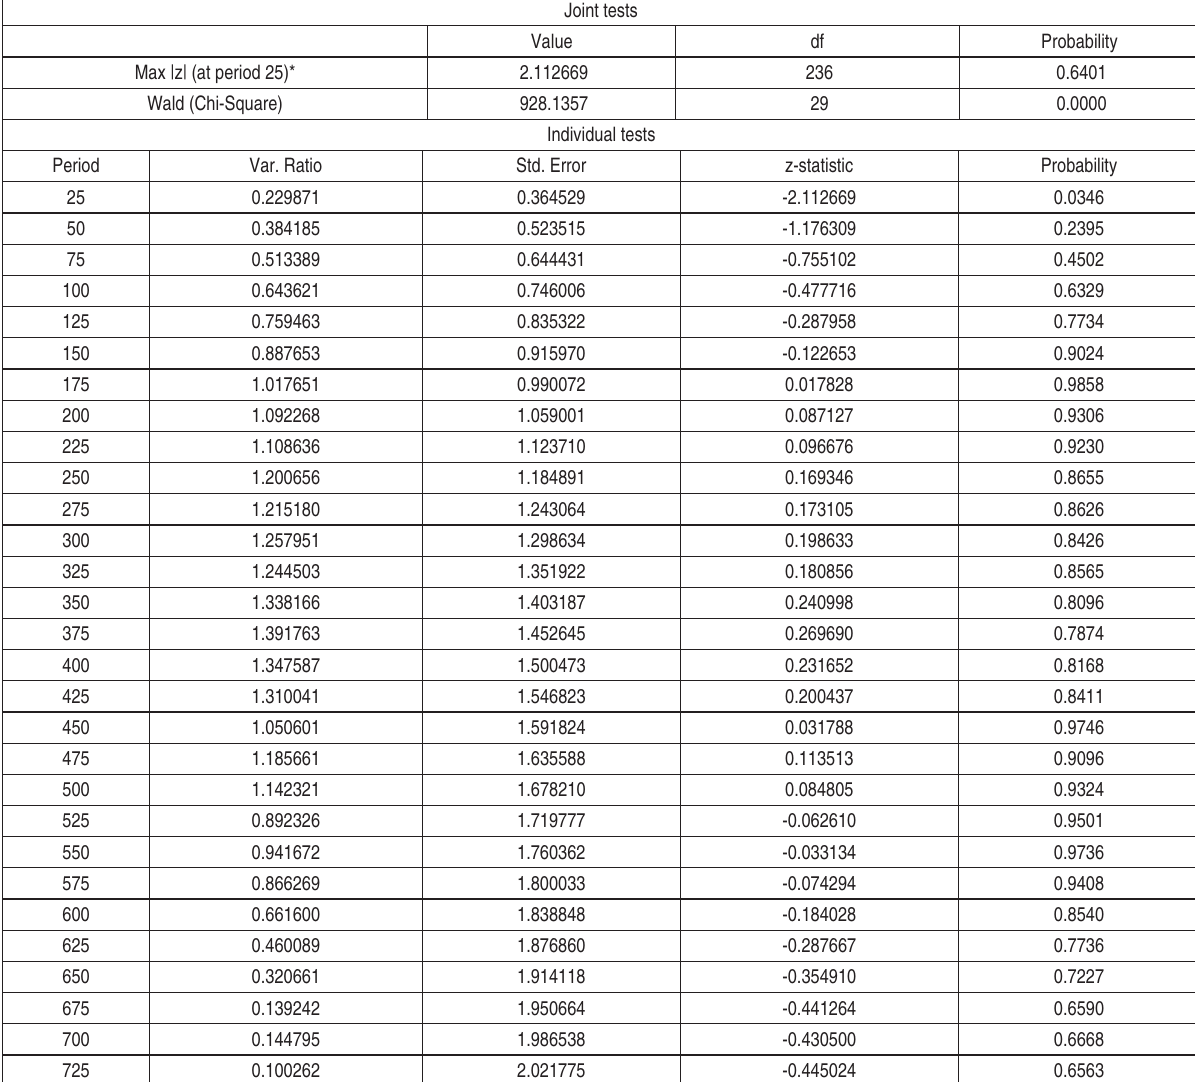
Table 4 below. Table 4.Variance ratio test of the NSE 20 share index (weekly